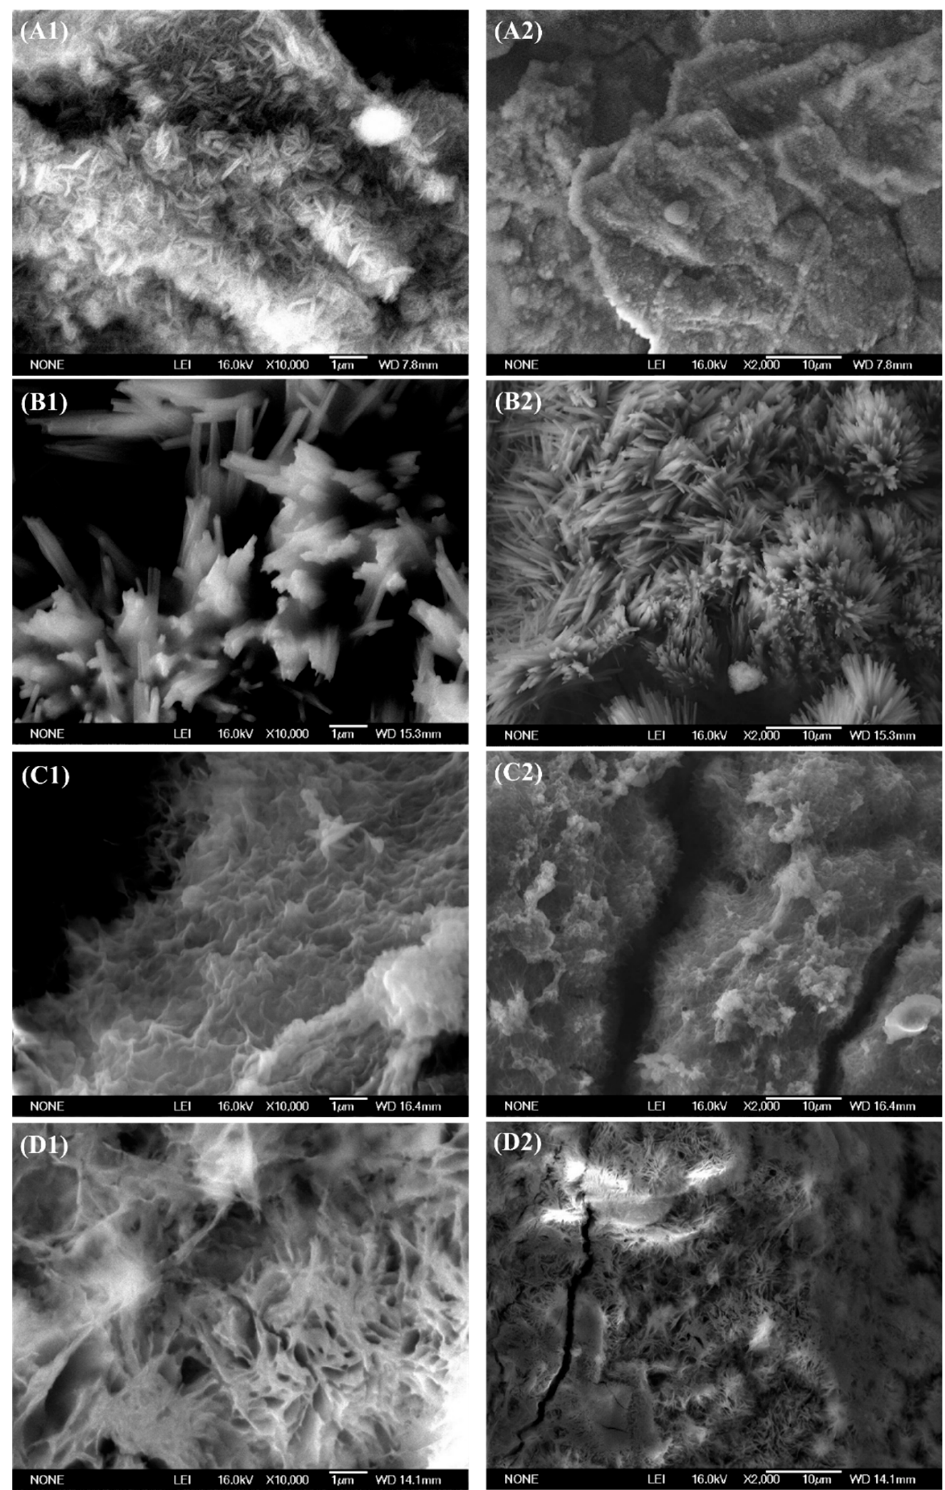
Figure 7. Influence of different inorganic metabolites of SRB on the morphology of magnesium alloys observed by SEM. ( A1 , A2 ): alloy AZ31B immersed in 2 mmol sulphide ions, ( B1 , B2 ): alloy AZ63B immersed in 2 mmol sulphide ions, ( C1 , C2 ): alloy AZ31B immersed in 0.4 mmol phosphate ions, and ( D1 , D2 ): alloy AZ63B immersed in 0.4 mmol phosphate